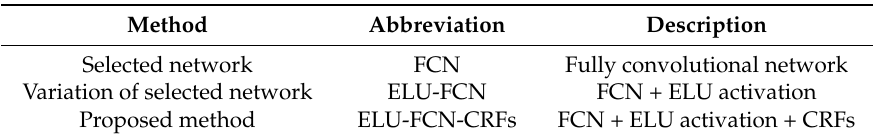
Table 1. Variations in selected convolutional neural network (CNN) models: exponential linear unit (ELU) activation function and conditional random fields